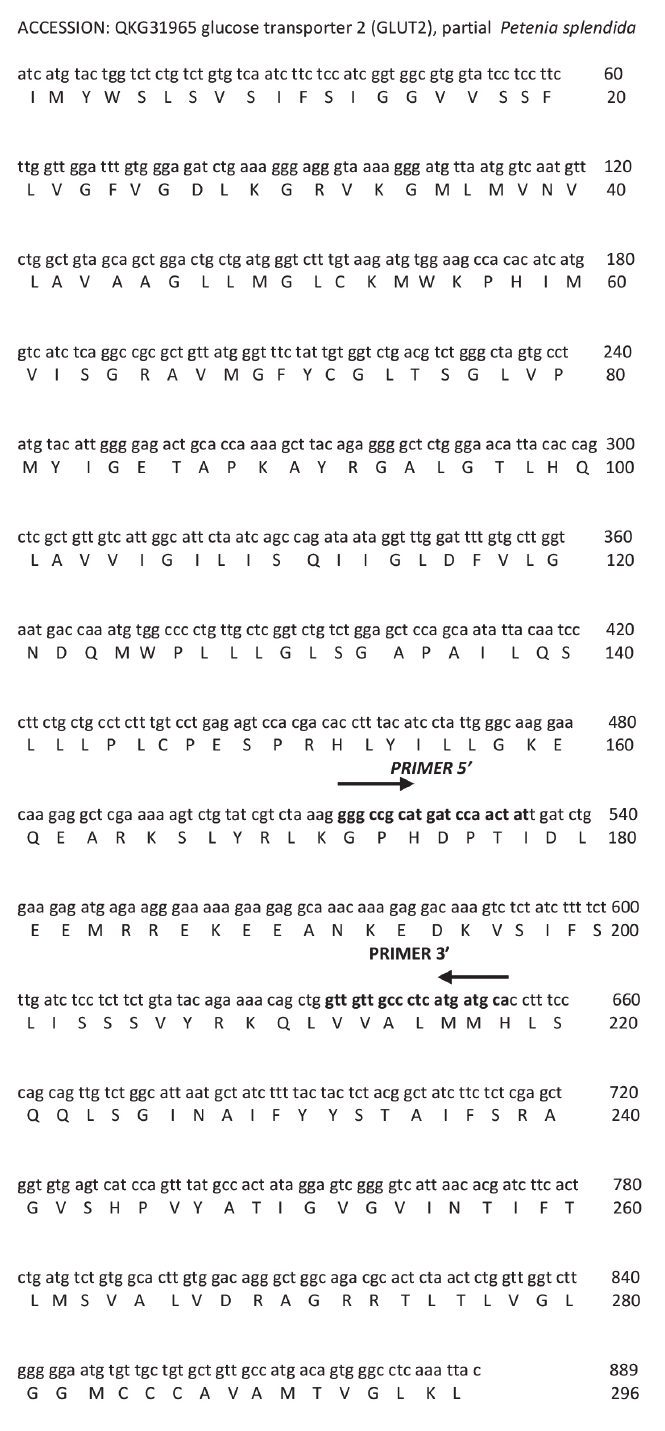
FIGURE 1 | Partial sequence of nucleotides and amino acids (AA) encoding glut2 (glucose transporter 2) from Petenia splendida taken from Gen Bank to design specific oligonucleotides for